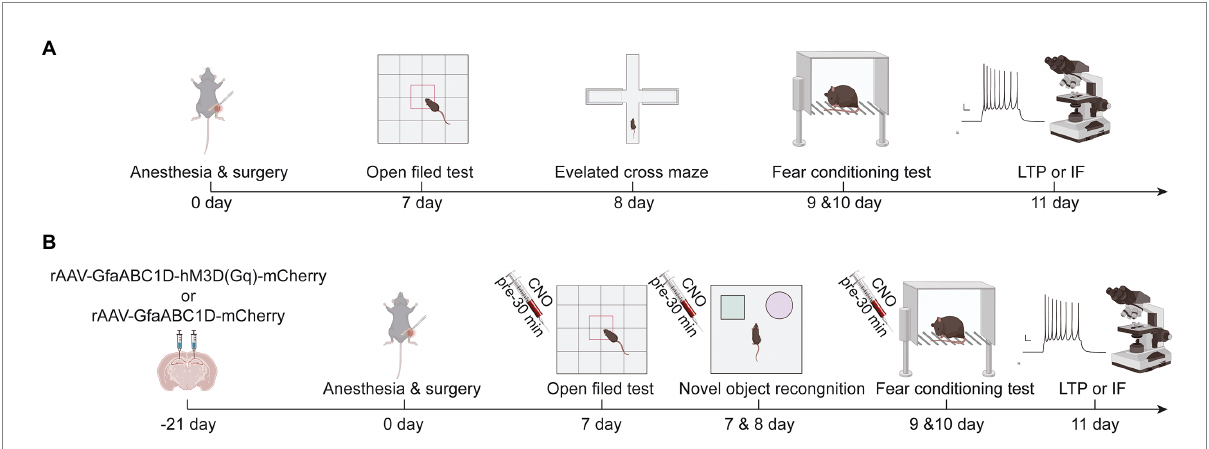
FIGURE 1 (A) Schematic diagram of experimental procedure of aging mice in group C and TF, (B) Schematic diagram of experimental procedure of aging mice in AAV mCherry/CNO group, AAV hM3D/Saline group and AAV hM3D/CNO group. Images were created on the BioRender web